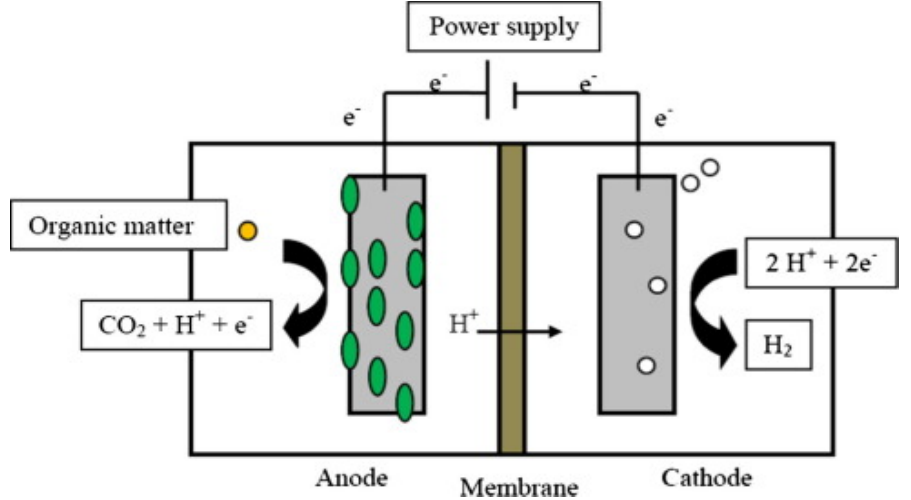
Figure 3. Schematic of double–chamber MEC operation and construction. Reproduced with permis- sion from Ref. [19].